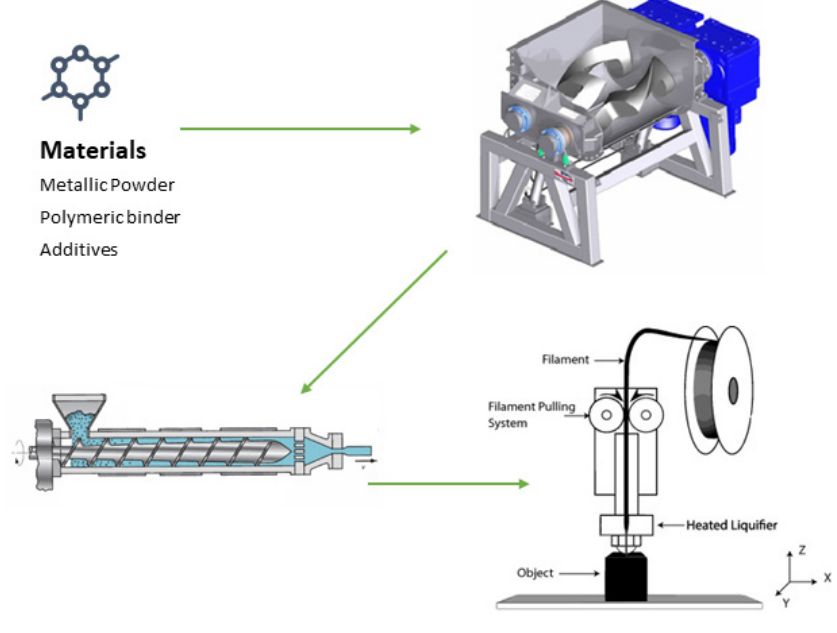
Figure 1. Flowchart of the MEX process (adapted from [21,22]). Prealloyed powder is the elective powder for SLM because the elemental Ni and Ti powder is predisposed to form NiTi 2 and Ni 3 Ti intermetallics due to its high contamination by N 2 and O 2 . Thus, the option for MEX was also prealloyed powder, with the expectation to yield the main targets of the SLM process, in particular to attain maximum densification and a more uniform microstructure. The virgin prealloyed NiTi powder particles were supplied by LPW Technology Ltd. (Runcorn, UK), nickel powder particles by Sandvik (Sandviken, Sweeden), and TiH 2 powder particles by Reade Advanced Materials (Riverside, RI, USA). Particle size distribution (PSD) was evaluated using laser diffraction spectrometry LDS, Malvern Panalytical (Egham, UK) with a Malvern Mastersizer 3000. A Philips X’Pert diffractometer (Egham, UK) at 40 kV with Bragg–Brentano geometry ( θ –2 θ ), with cobalt anticathode ( λ (k α 1) = 0.178897 nm and λ (k α 2) = 0.179285 nm), and a current intensity of 35 mA was used to perform phase analysis. The x-ray diffraction scans were carried out from 20 to 100 ◦ in steps of 0.025 ◦ , with an acquisition time of 1 s per step. Characteristics of NiTi prealloyed powder, binder, and additives are described else- where [8]. Phase analysis by X-ray diffraction (XRD) of the prealloyed powder